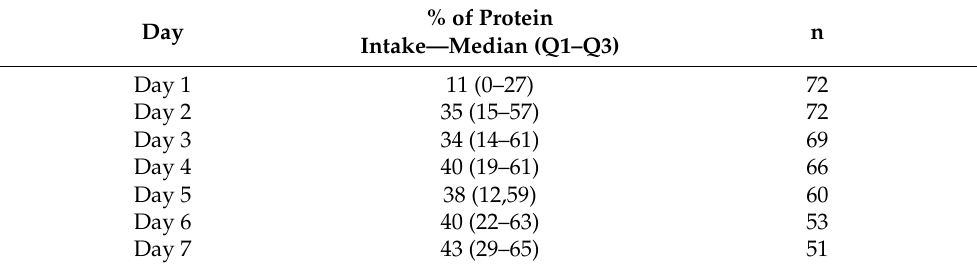
Table 3. Percent of ESPEN protein target fulfillment (i.e., protein intake 1.3 g/kg BW).